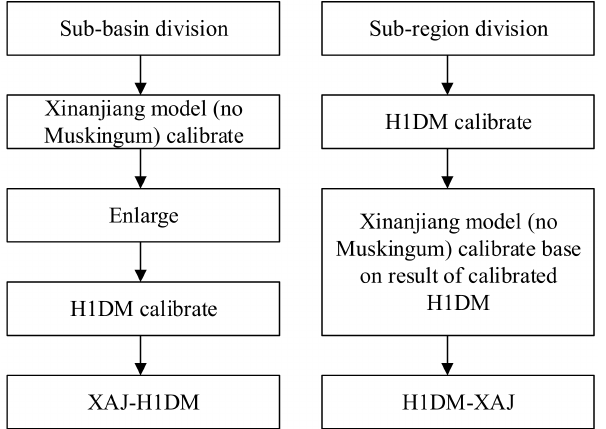
Figure 3. Flow chart of the Xinanjiang model with the one-dimension hydrodynamic model, XAJ-H1DM ( left ) and H1DM-XAJ ( right ).